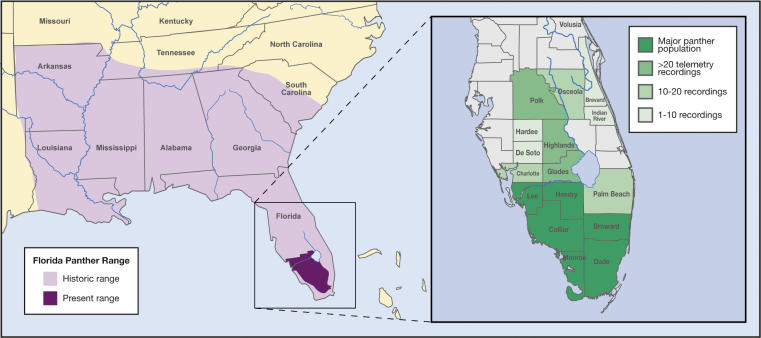
The Historic and Current Range of the Florida PantherThe “Florida” panther is really a misnomer, experts say. This mountain lion subspecies once inhabited most of the southeastern United States, north to Tennessee and west to Texas—until human persecution and encroachment extirpated the panther from 95% of its historic range. The modern Florida panther is an artifact of these forces. Genetic drift and inbreeding led to the cat's trademark crooked tail and other unique characteristics, while unchecked development eliminated the panther from every area but southwest Florida—the last place to be developed.(Illustration: Rusty Howson)